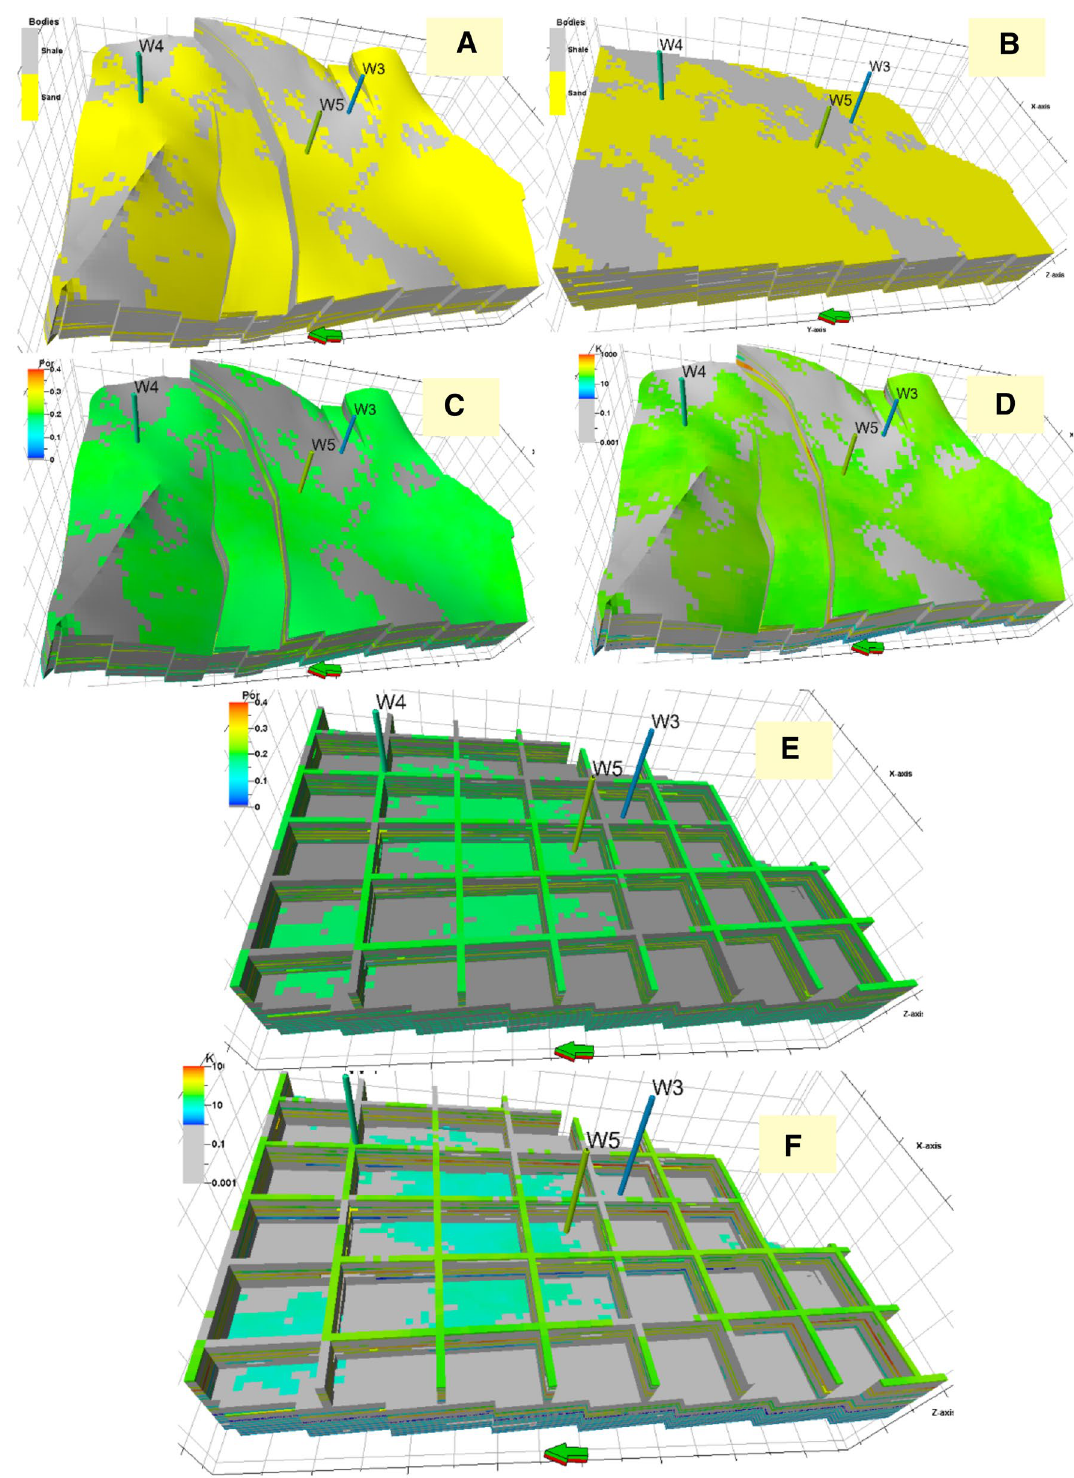
Fig. 8 3D property models and their sections established with the application of sequential indication simulation and sequential Gauss- ian simulation. a 3D depositional sand body model of the study area; b 3D depositional sand body model through toggle simbox view without taking fault into consideration; c 3D porosity model of the